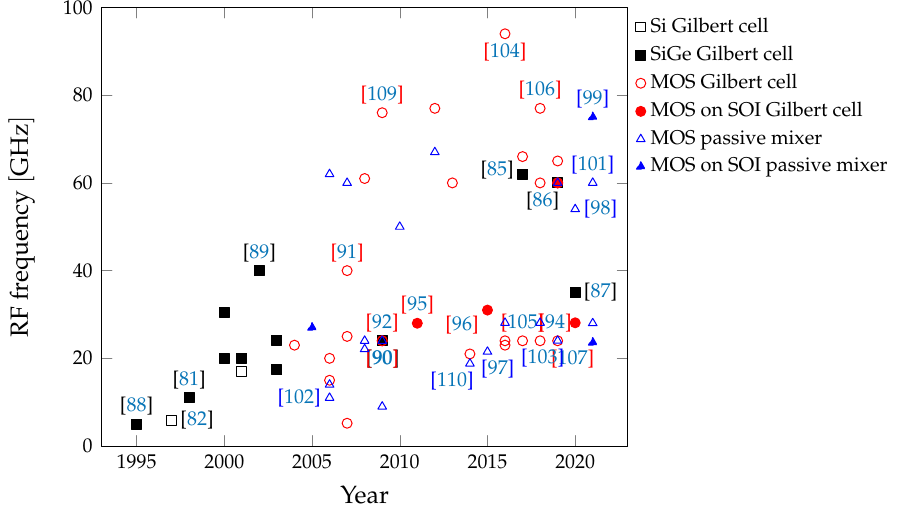
Figure 19. Mixers technological trends: technological node versus RF operating frequency